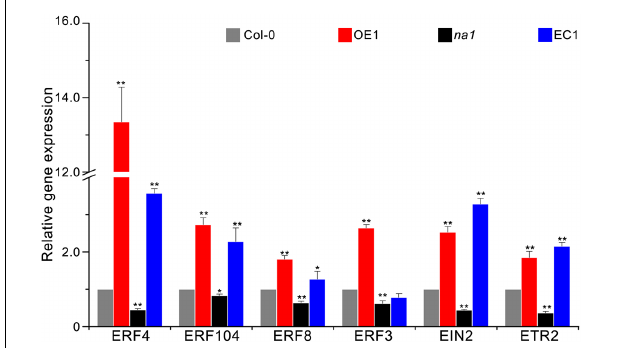
FIGURE 5 | GbaNA1 regulates the expression levels of ethylene signaling-associated genes. Relative expression of six ethylenesignaling-associated genes in A. thaliana lines. Wild type Col-0, GbaNA1 -overexpression transgenic line OE1, GbaNA1 ortholog mutant na1 , and a GbaNA1 overexpression transgenic line of na1 were inoculated with a suspension of 5 × 10 6 conidia/mL of V. dahliae (strain Vd991) using a root-dip method. Root samples were collected for RNA isolation and cDNA synthesis 24 h after inoculation. Relative expression of ethylene signaling-associated genes was assessed by reverse transcription-quantitative PCR using the comparative threshold 2 - (cid:49)(cid:49) CT method and A. thaliana UBQ1 as a reference. Values represent averages of three independent biological replicates. Error bars represent standard errors. Asterisks ( ∗ ) and double asterisks ( ∗∗ ) represents statistical significance of P < 0.05 and P < 0.01, respectively, according to an unpaired Student’s t